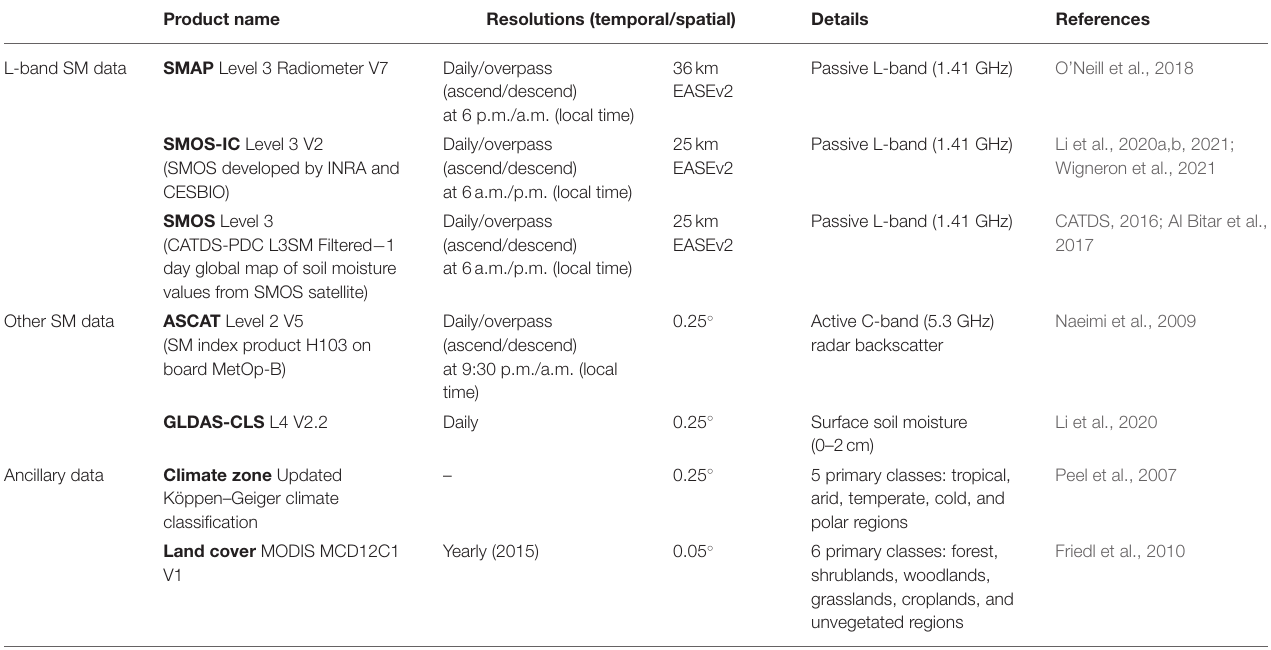
TABLE 2 | Summary of datasets used in this